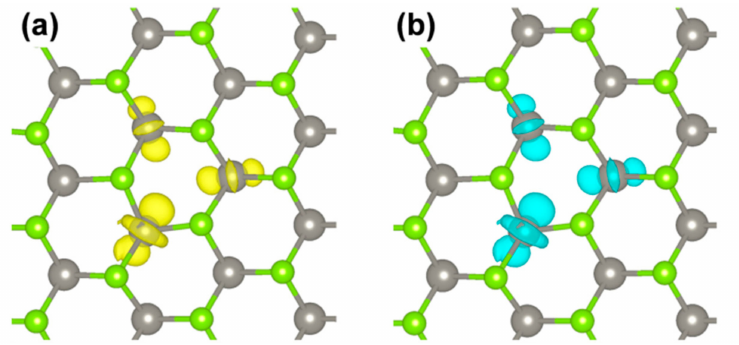
Figure 11. Charge plots for the e − ( a ) and the h + ( b ) in the triplet exciton by HSE/CRY14. The isosurface level is 0.006 electron/bohr 3